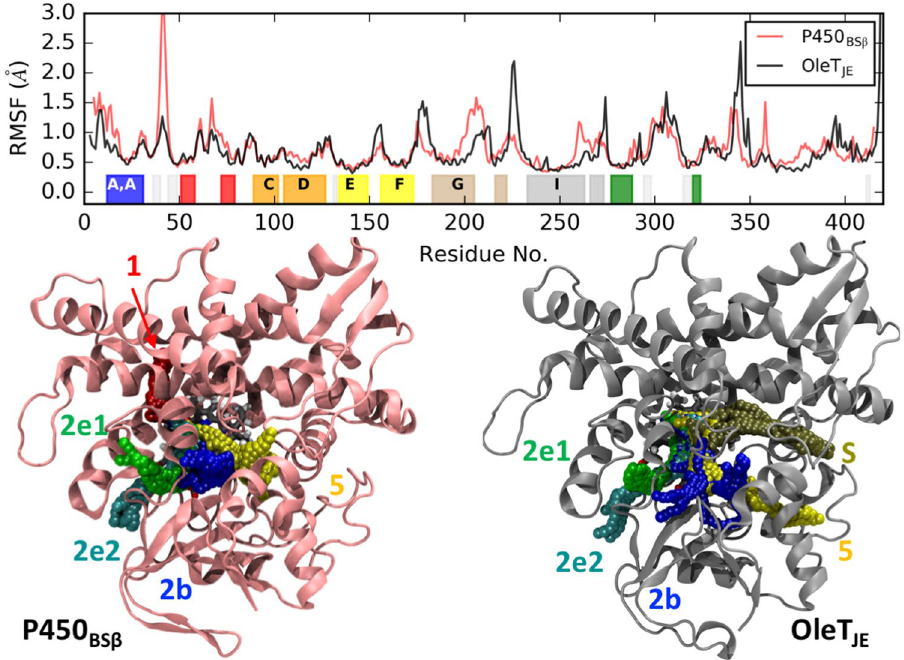
Figure 2. Apo state dynamics: (Top) Root Mean Square Fluctuations (RMSFs) enable comparisons of flexible regions in P450 BS β and OleT JE . The important structural domains of the protein are highlighted and correspond to the color-coded domains depicted in Fig. 1. (Below: Left and Right) CAVER analysis reveals dominant protein channels connecting the enzyme surface to the active site in P450 BS β (Left) and OleT JE